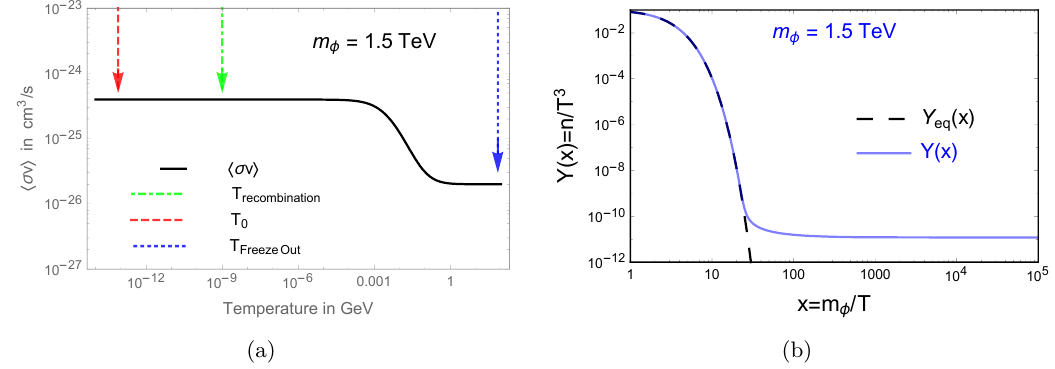
Figure 2 . (a) Dependence of total DM thermal average annihilation cross section h σv i on DM temperature when h σv i φ,φ → h,h = 2 × 10 − 26 cm 3 / s, ξ η ξ φ ξ e ζ 2 = 2 . 6 × 10 24 and ξ η ξ φ ξ µ ζ 2 = 1 . 15 × 10 25 (e.g., ξ e = 2 . 6 × 10 − 4 , ξ µ = 1 . 15 × 10 − 3 , ξ φ = 10 14 , ξ η = 10 14 ), m φ = 1500 GeV, m η = 2 m φ